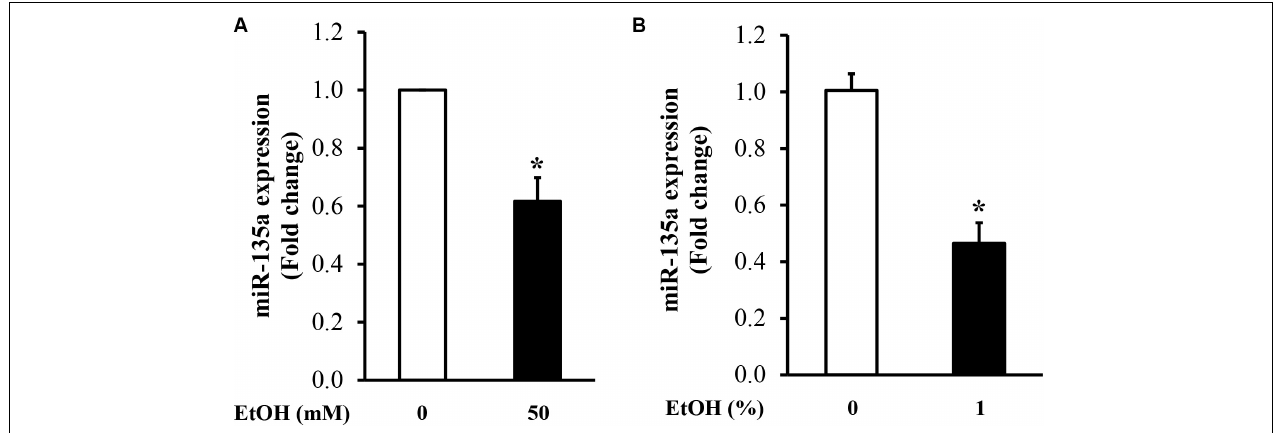
FIGURE 1 | Ethanol exposure decreased the expression of miR-135a in neural crest cells (NCCs) exposed to 50 mM ethanol for 24 h (A) and zebrafish embryos treated with 1% ethanol and collected at 24 h post-fertilization (hpf; B ). The expression of miR-135a was determined by qRT-PCR, as described in the section “Materials and Methods”. Data are expressed as fold change over control and represent the mean ± SD of three separate experiments. * p < 0.05 vs. control.